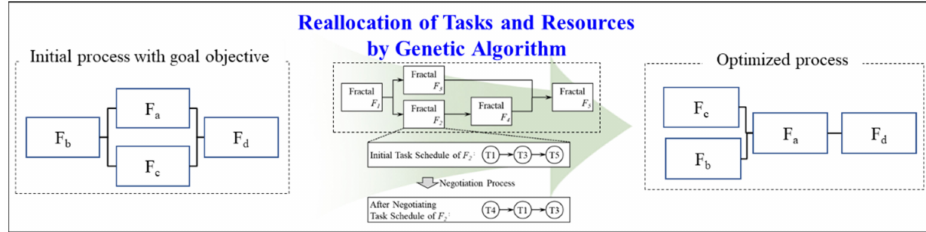
Figure 16. Negotiation model in